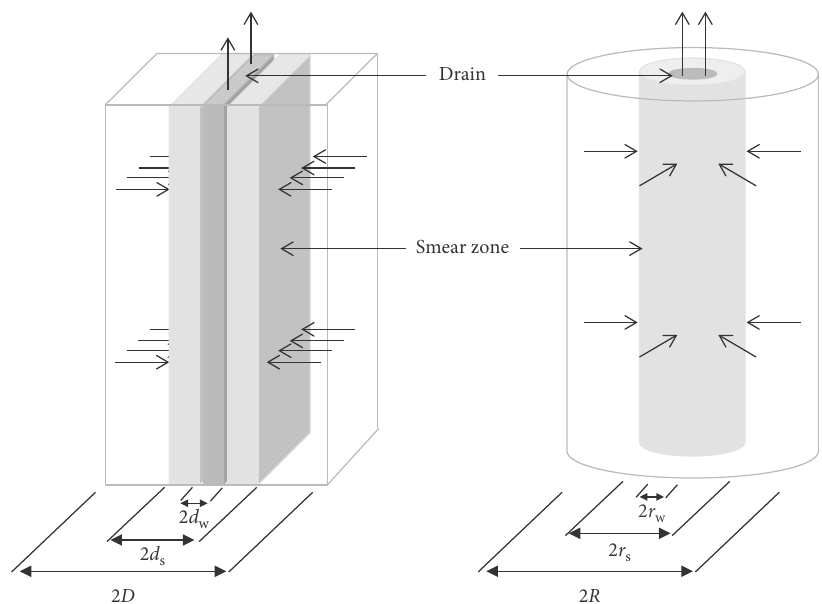
Figure 2: Equivalent plane strain unit cell (a) and axisymmetric unit cell (b) (modified from Reference [7]).